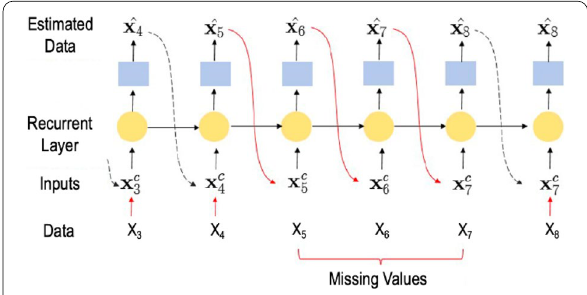
Figure 7 Time series imputation with RNN, adapted from Ref.